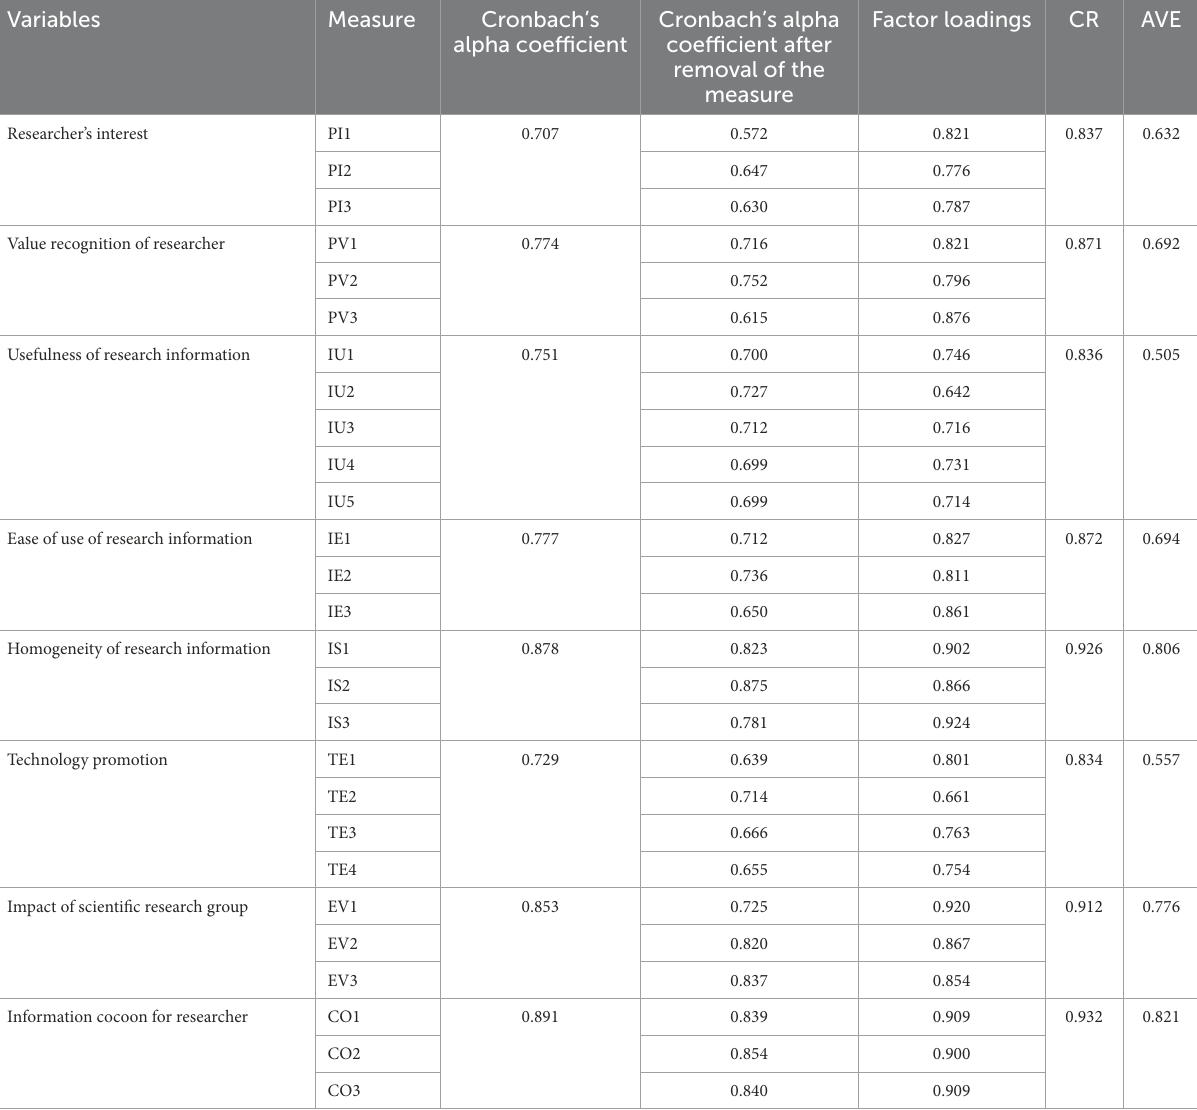
TABLE 1 Reliability